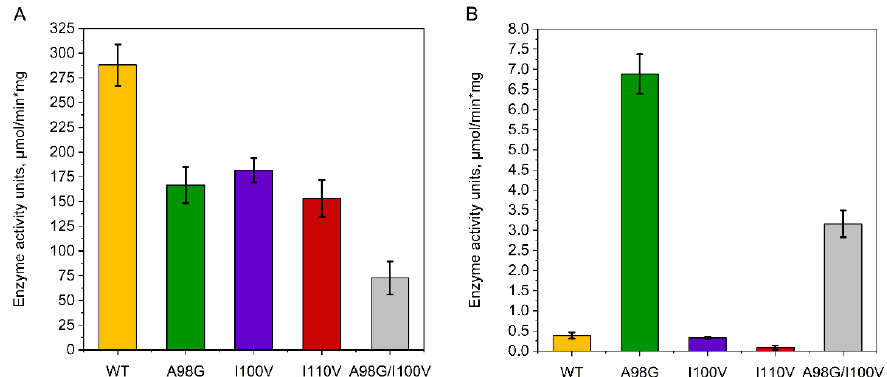
Figure 6. Enzyme assay of wild type Eco RK and various mutants for ( A ) D-ribose phosphorylation (2 mM) ( B ) D-arabinose phosphorylation (50 mM). Data represented in mean values and standard deviation (in three repeats).